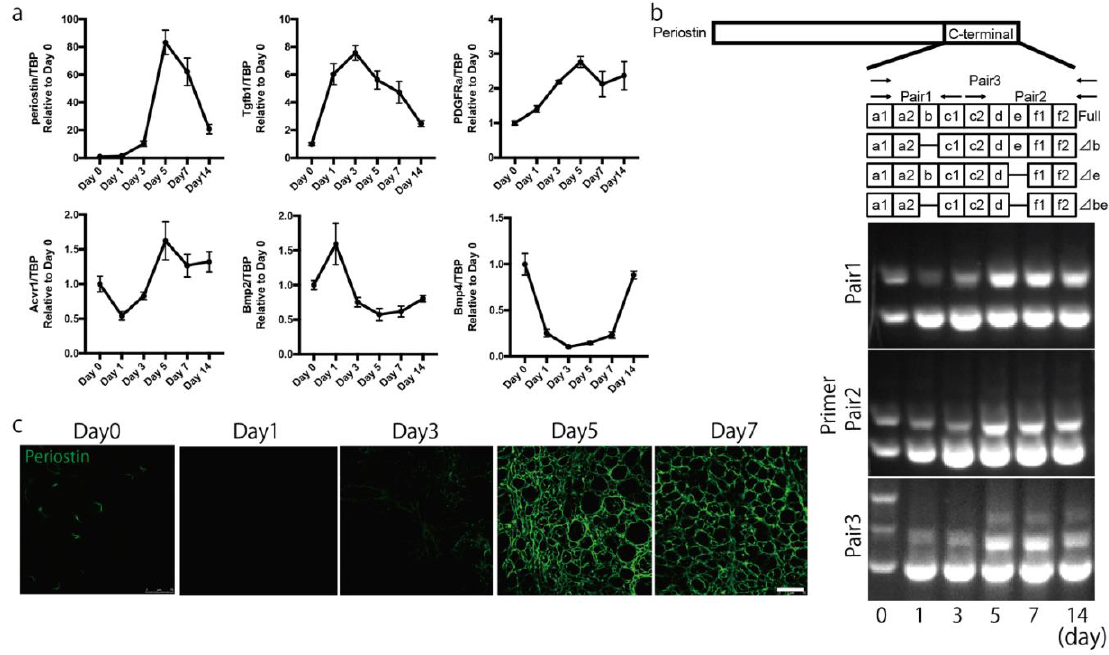
Figure 2. Expression of periostin is increased during muscle regeneration. ( a ) Expression of periostin, Tgfβ1, PDGFRα, Acvr1, Bmp2, and Bmp4 during muscle regeneration by quantitative PCR. ( b ) Expression of periostin isoforms during muscle regeneration. ( c ) Immunohistochemical analysis of periostin during muscle regeneration. Bar: 75 μm. n = 3. Error bars indicate SEM.